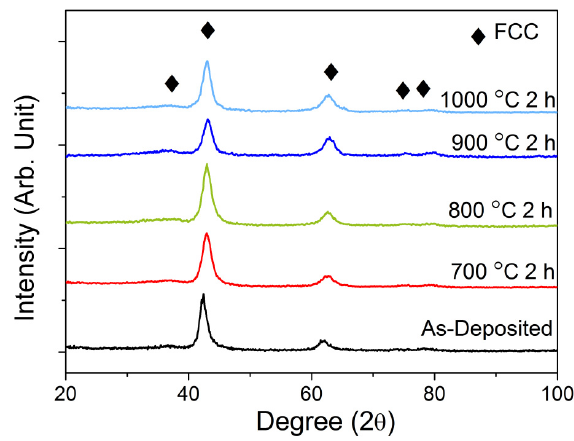
Figure 1. XRD patterns of as-deposited and vacuum-annealed (Al 0.34 Cr 0.22 Nb 0.11 Si 0.11 Ti 0.22 ) 50 N 50